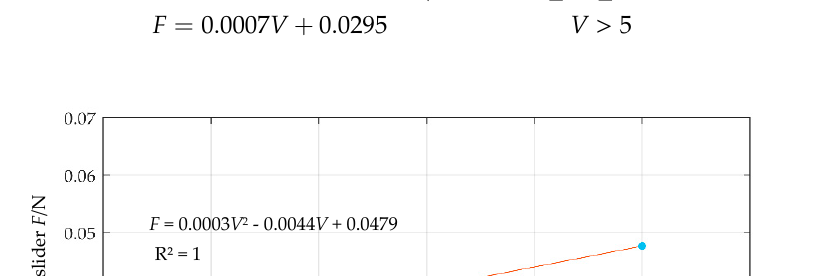
Figure 5. Friction-sliding speed curve of the slider.